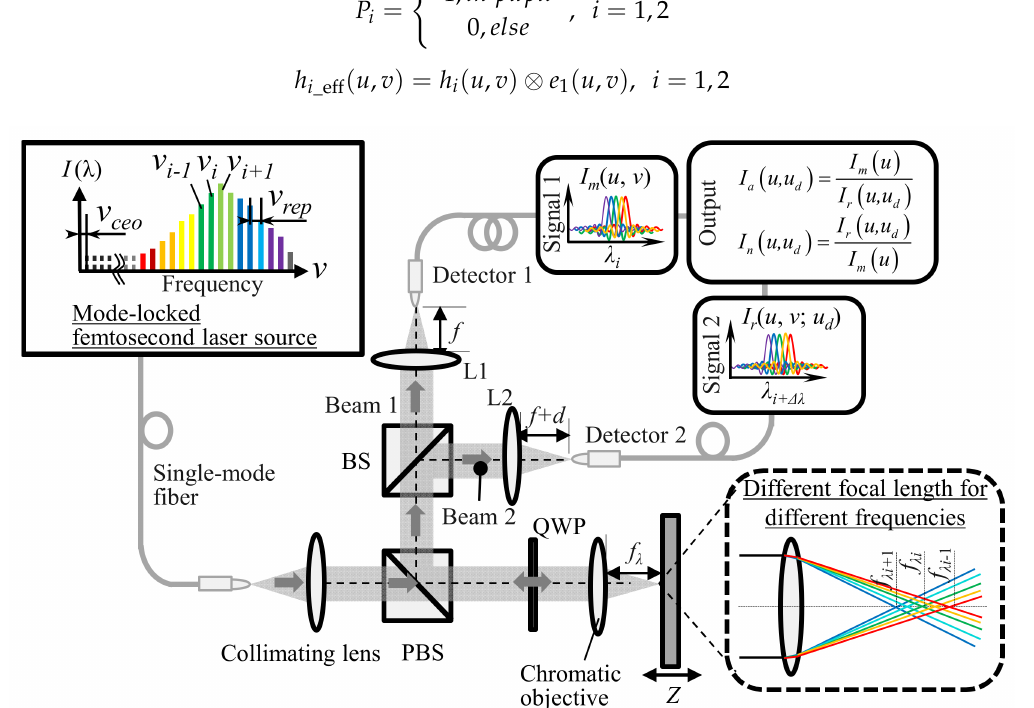
Figure 1. Schematic diagram of the fiber-based dual-detector chromatic confocal configuration with a mode-locked femtosecond laser